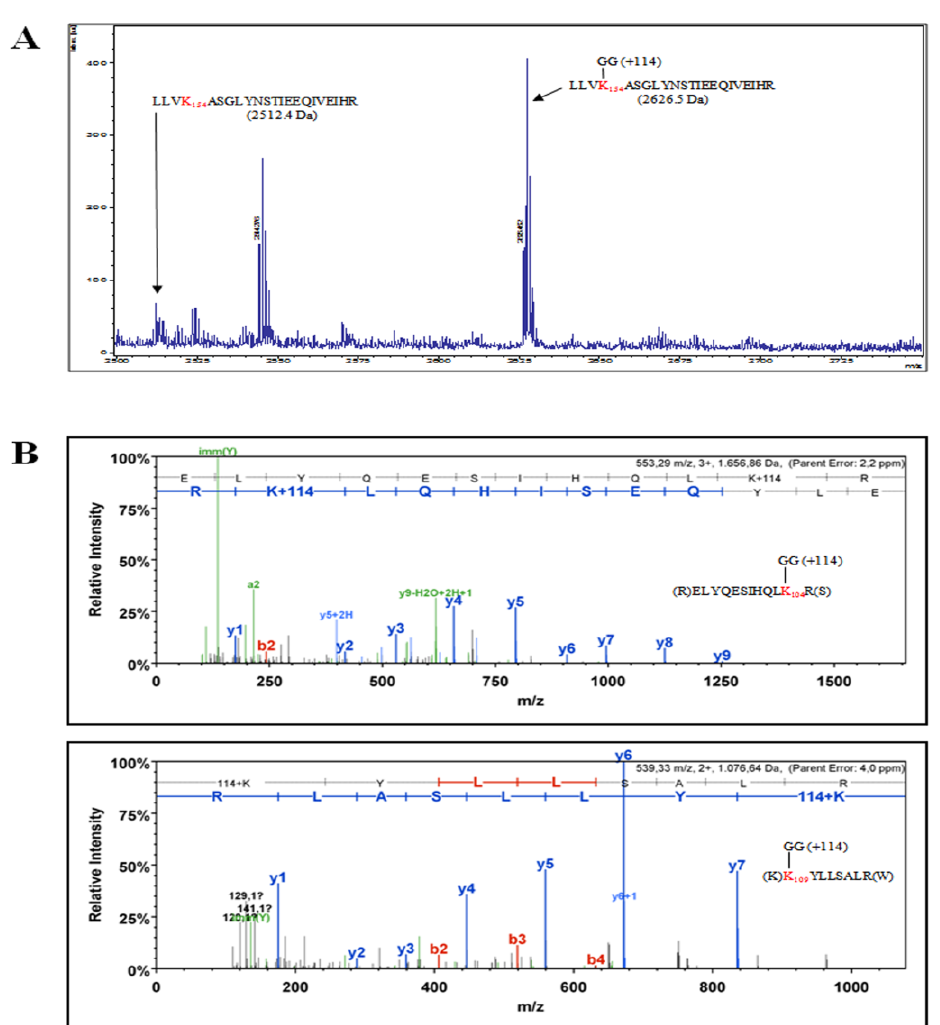
Figure 5. The NSs protein, enriched from cell lysate of transfected cells, was analyzed by mass spectrometry in an attempt to identify lysine residues targeted for specific ubiquitination. ( A ) MS1 mass spectrum (Department of Life Sciences, University of Siena, Siena) showing the identification of TOSV NSs peptide containing the ubiquitinated lysine residue at position 154 and ( B ) MS2 mass spectrum (Cogentech S.c.a.r.l., Milan, Italy) showing TOSV NSs peptides ubiquitinated on lysines at positions 109 and 104.